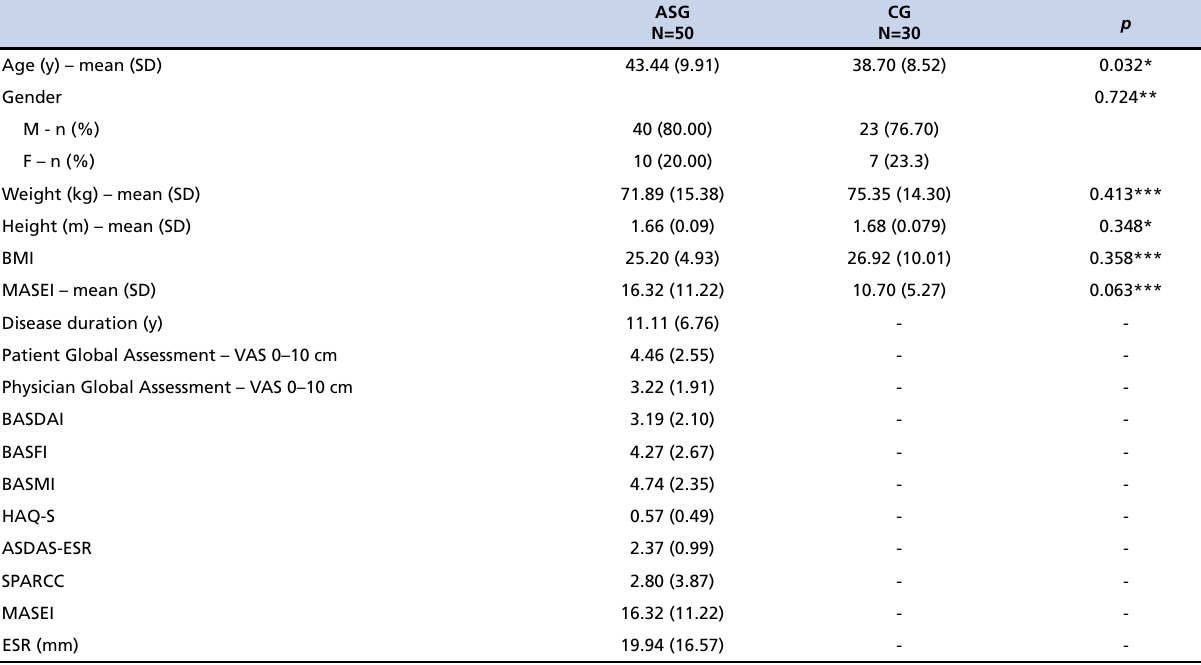
Table 1 - Demographic and clinical characteristics of the